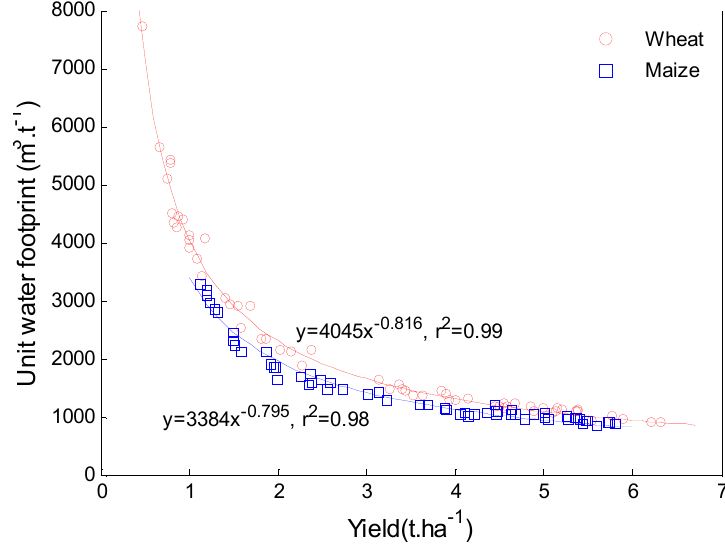
Figure 4. The relationship of unit WF and yield of wheat and maize in the HRB over the period